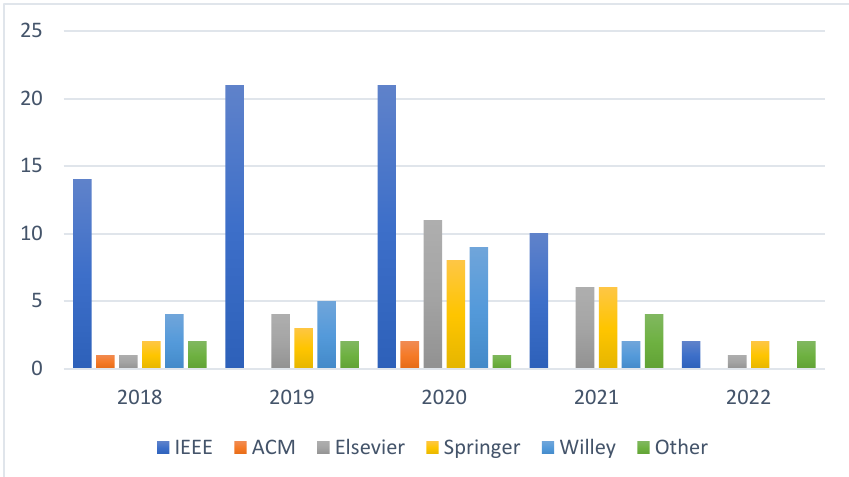
Figure 2. Classifying published articles according to their year and publishers.